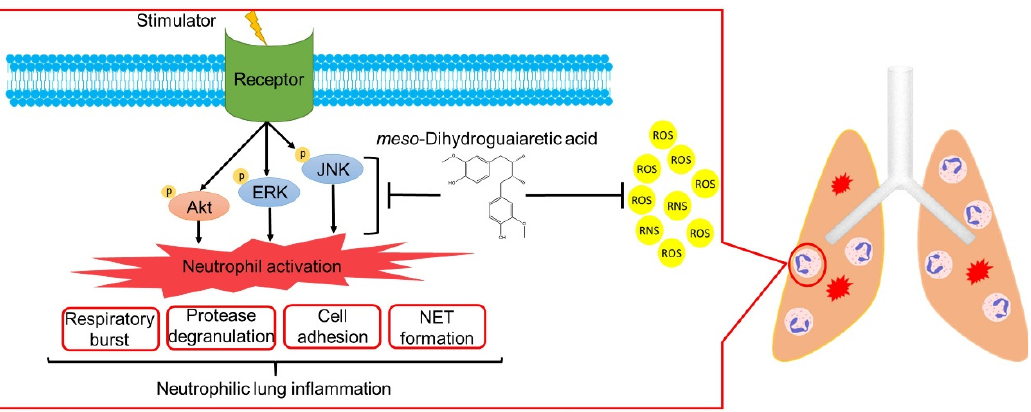
Figure 9. meso -Dihydroguaiaretic acid (MDGA) suppresses neutrophil respiratory burst, protease degranulation, cell adhesion, and NETs by inhibiting ERK, JNK, and Akt signaling and direct ROS